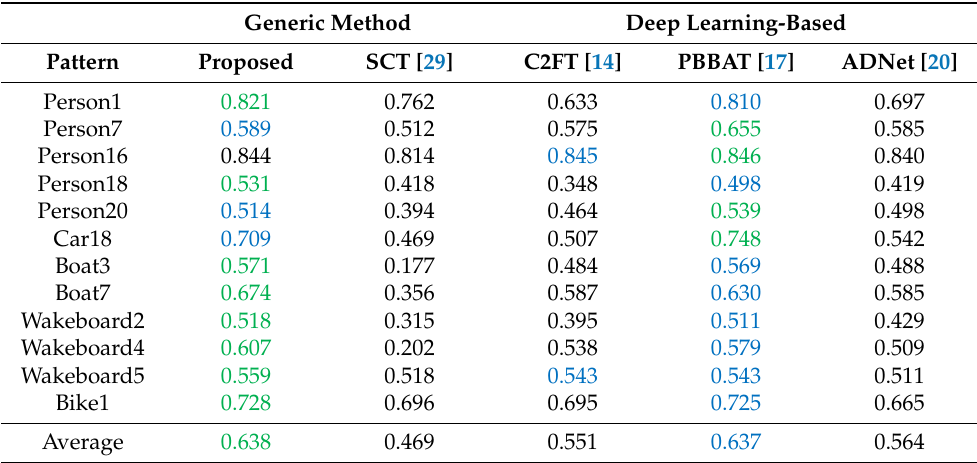
Table 2. The success result of the AUC score. The best two precisions for each pattern are shown in blue and green colors,